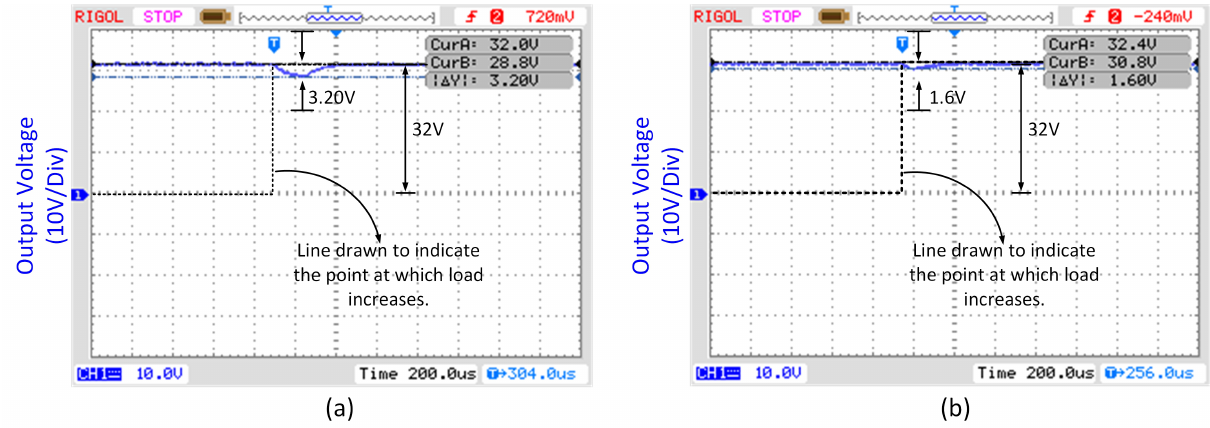
Figure 8. Results showing robustness of the PI and proposed DISMC with PEMFC. ( a ) PI controller. ( b ) DISMC